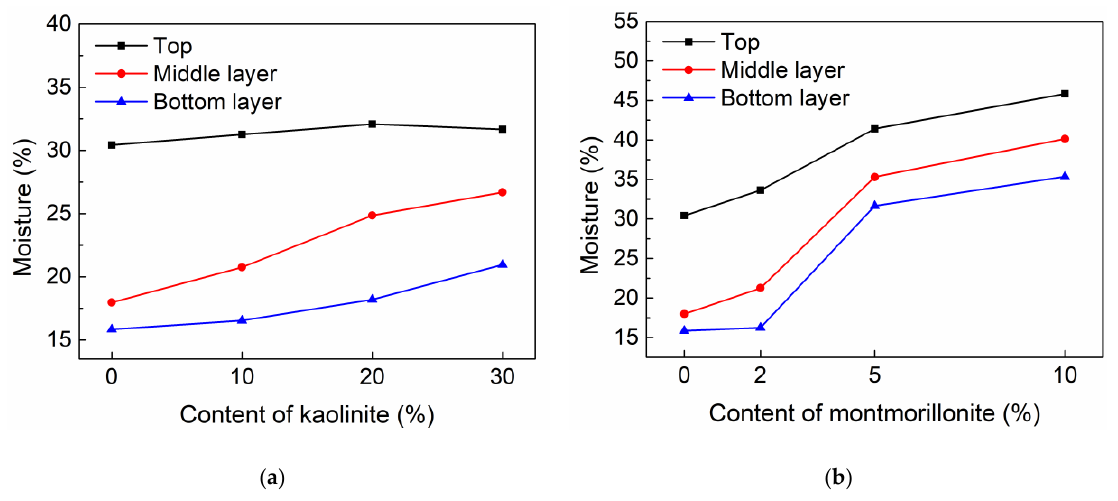
Figure 8. Moisture in different parts of filter cakes for cases with different contents of ( a ) kaolinite and ( b ) montmorillonite.